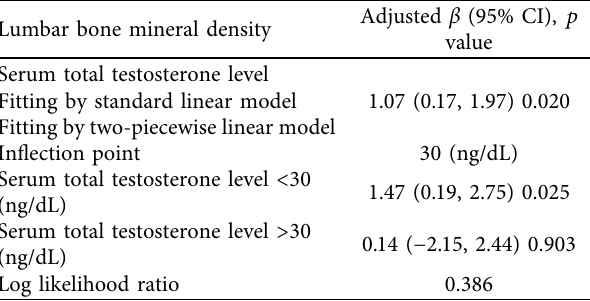
Age, race, body mass index, education level, income to poverty ratio, moderate activities, age since menopause, blood urea nitrogen, serum uric acid, total protein, serum phosphorus, and serum calcium were